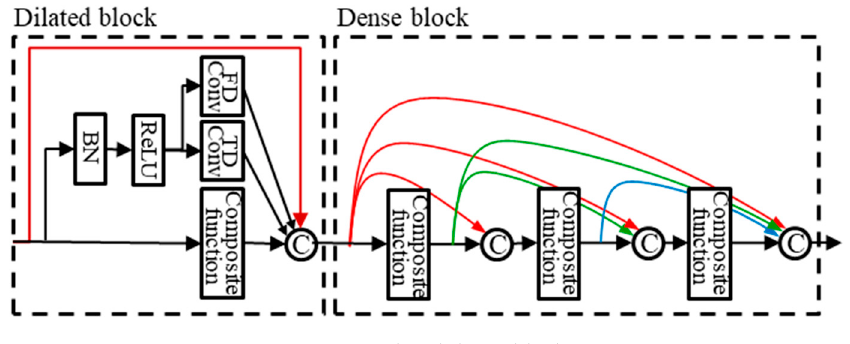
Figure 7. Dilated dense block.